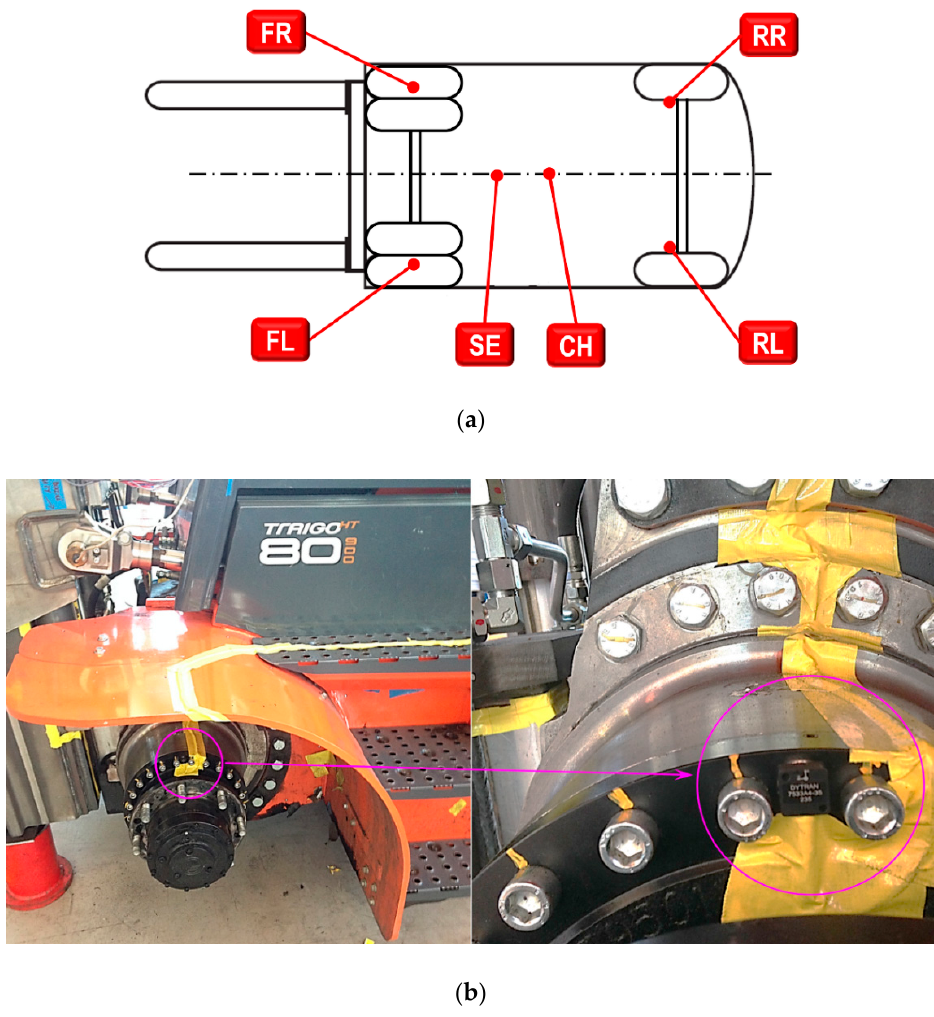
Figure 2. Sensor setup: ( a ) Schematics of the monitored locations; ( b ) close up of the accelerometer on the FL wheel hub.